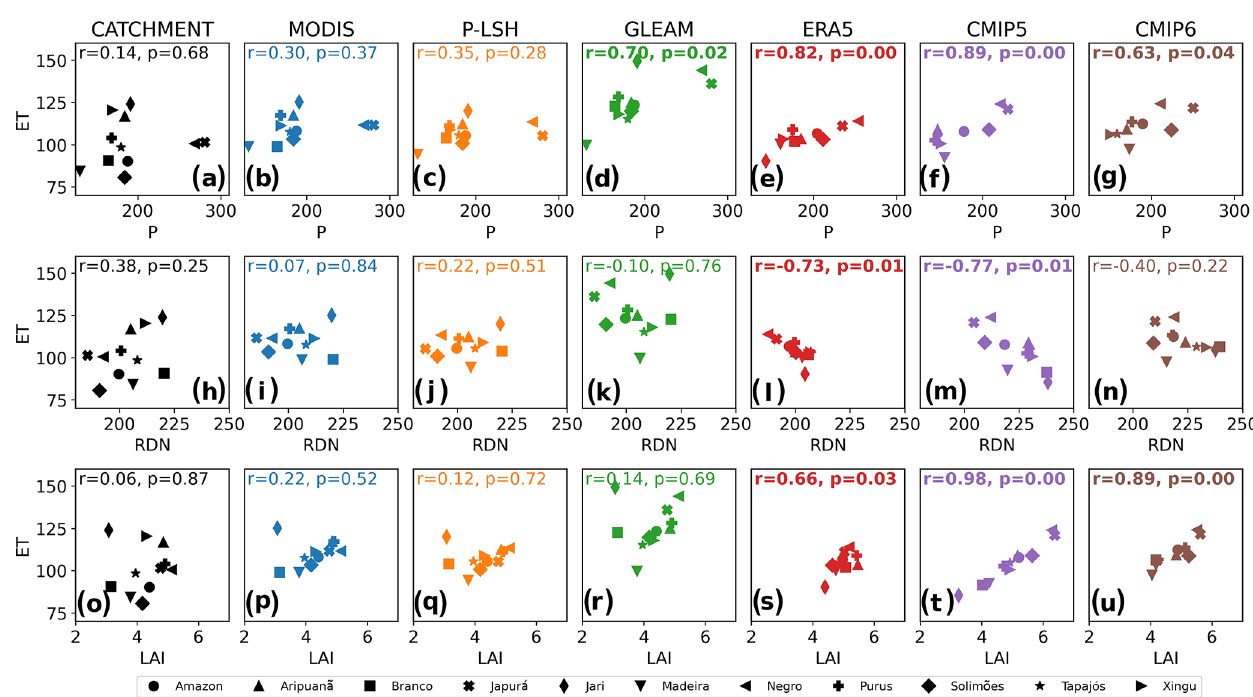
Figure 4. Controls on spatial variation in Amazon evapotranspiration (ET). Annual mean ET (in millimetres per month) for the Amazon and 10 sub-catchments (Fig. 1) from catchment balance, satellites (MODIS, P-LSH, and GLEAM), ERA5 reanalysis, and climate models (CMIP5 and CMIP6), plotted against (a–g) precipitation ( P , millimetres per month), (h–n) surface shortwave radiation (RDN, Wm − 2 ), and (o–u) leaf area index (LAI, m 2 m − 2 ). Satellite ET data are plotted against P from CHIRPS, RDN from CLARA-A1, and LAI from MODIS; ERA5 and climate model ET are plotted against ERA5 and model P , RDN, and LAI respectively. Data are from 2003 to 2013 with the exception of CMIP5, for which data are from 1994 to 2004. Note that the axes do not start at zero.